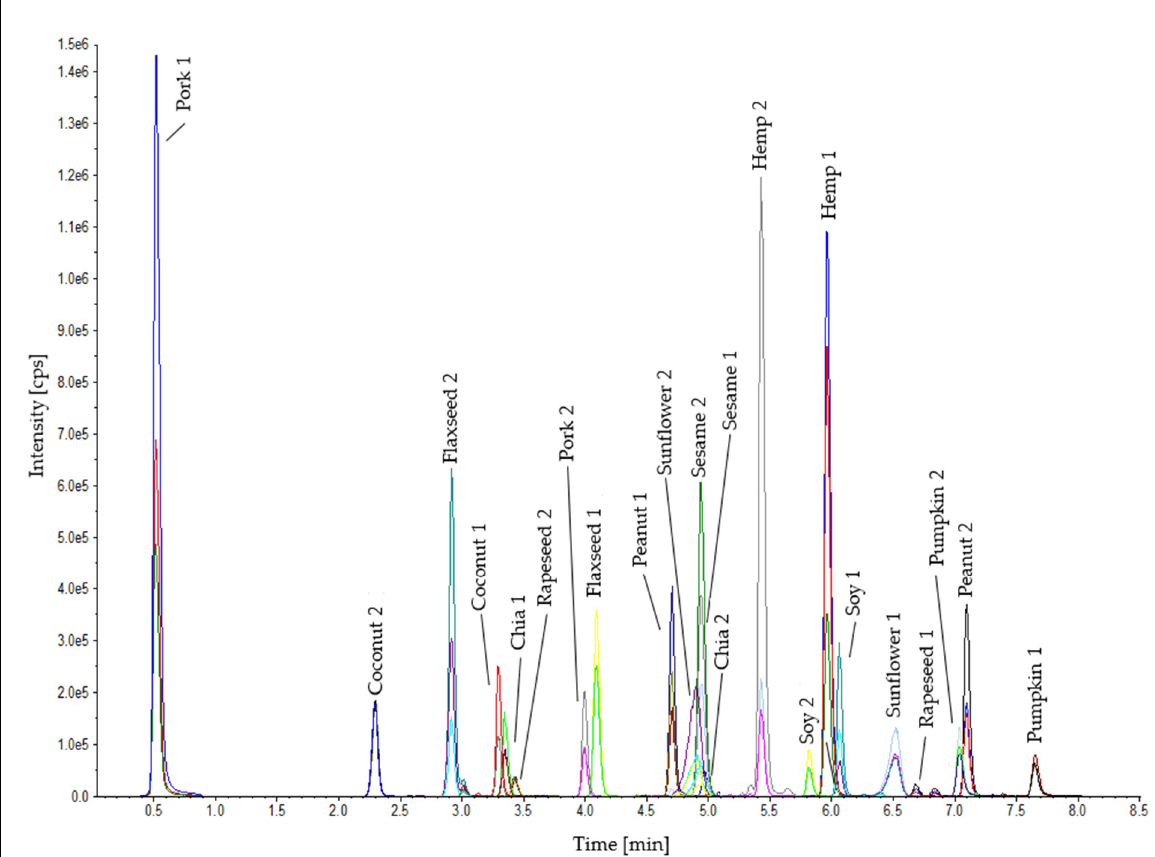
Figure 5. Chromatogram of the peptide markers for the oilseeds and the meat matrix in the test sausage T5 (0.1% oilseed protein, Table 1).